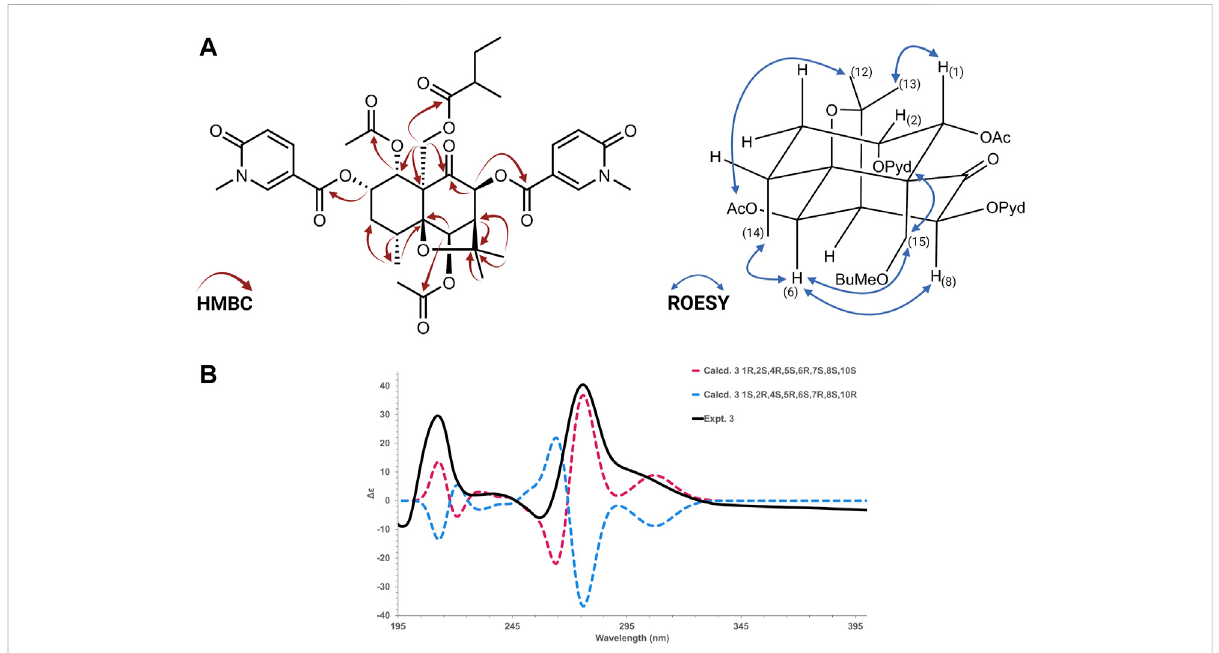
FIGURE 5 (A) HMBCKeyandROESYcorrelationsforthecompoundsisolatedfrom P.indica rootsextract. (B) ExperimentalandB3LYP/def2svp//B3LYP/6- 31G(d,p) calculated spectra in acetonitrile for compound 3